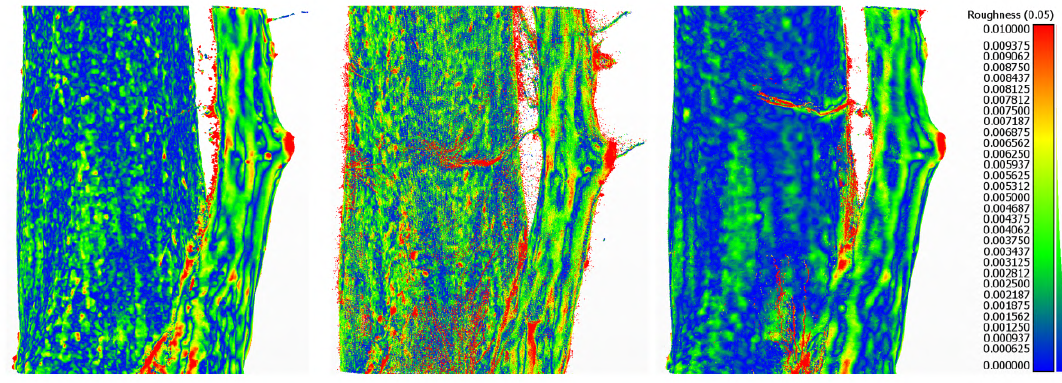
Figure 6. Point cloud roughness with a radius of 5cm using (a) Photogrammety, (b) TLS, (c) Azure